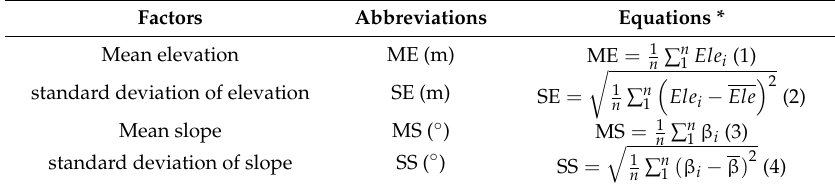
Table 2. Definition and calculation methods of the topographic